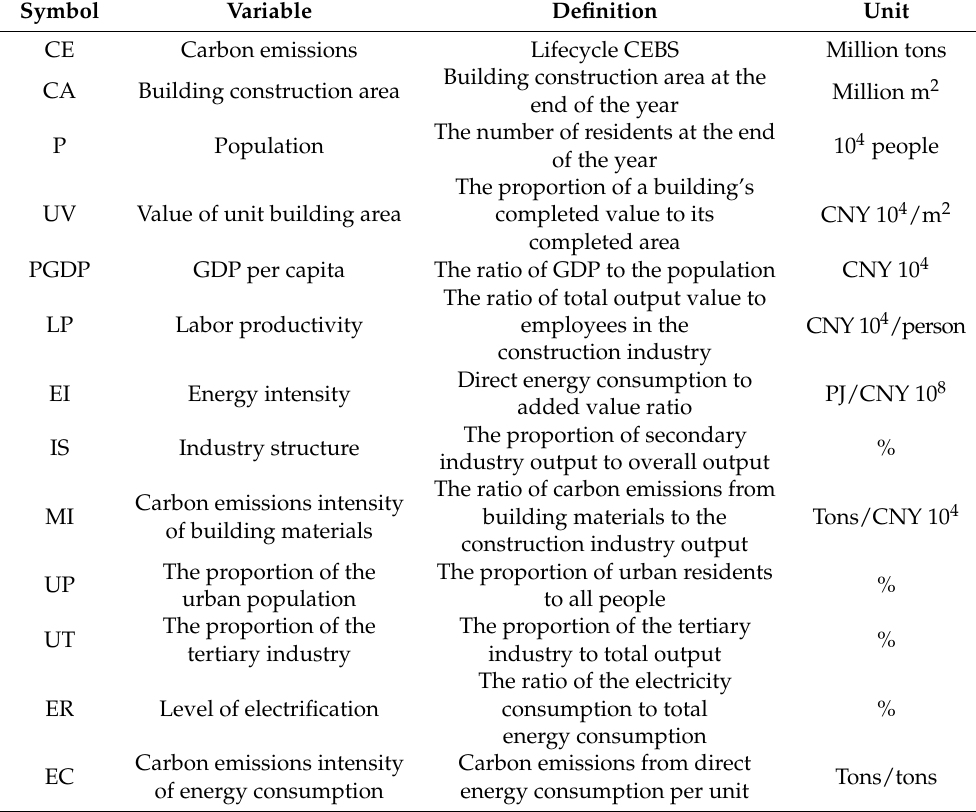
Table 1. Descriptions of the driving